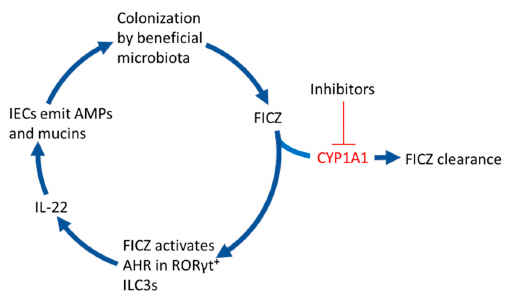
Figure 2. 6-formylindolo[3,2- b ]carbazole (FICZ) stimulates gut colonization by beneficial microbiota. When the CYP1A1-mediated clearance of microbially produced FICZ in the intestinal epithelium